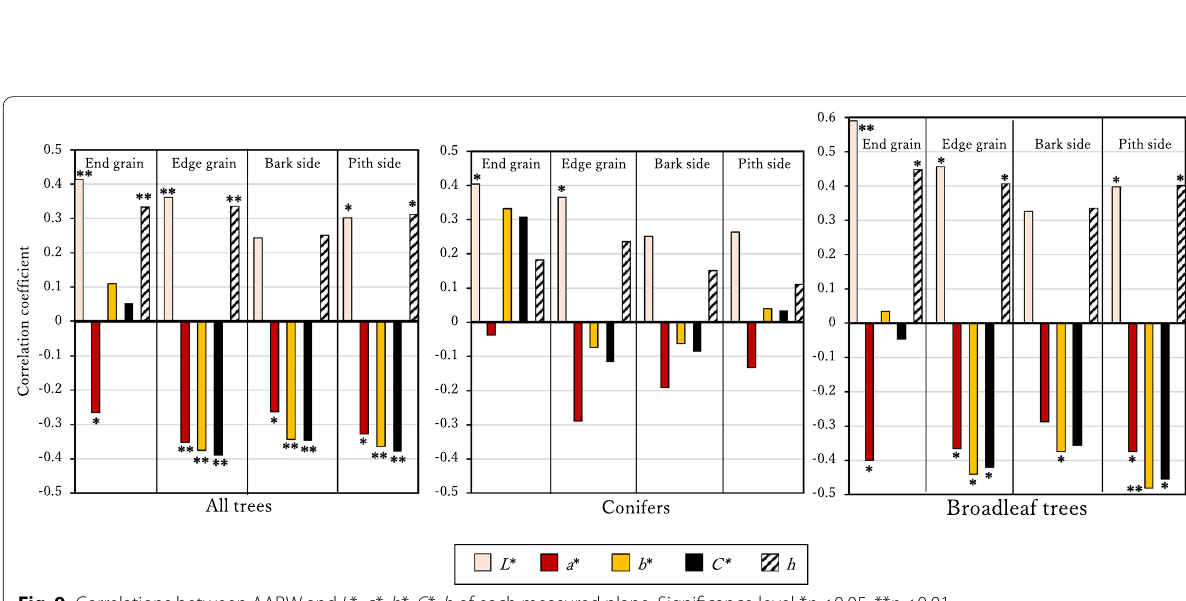
Fig. 9 Correlations between AARW and L *, a *, b *, C *, h of each measured plane. Significance level * p < 0.05, ** p <